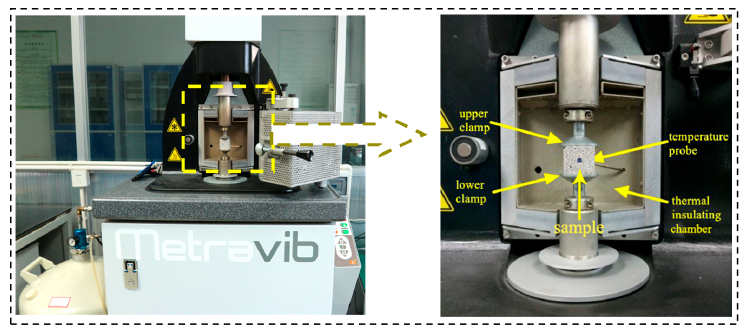
Figure 4. Test setup of dynamic mechanical analyzer (DMA).